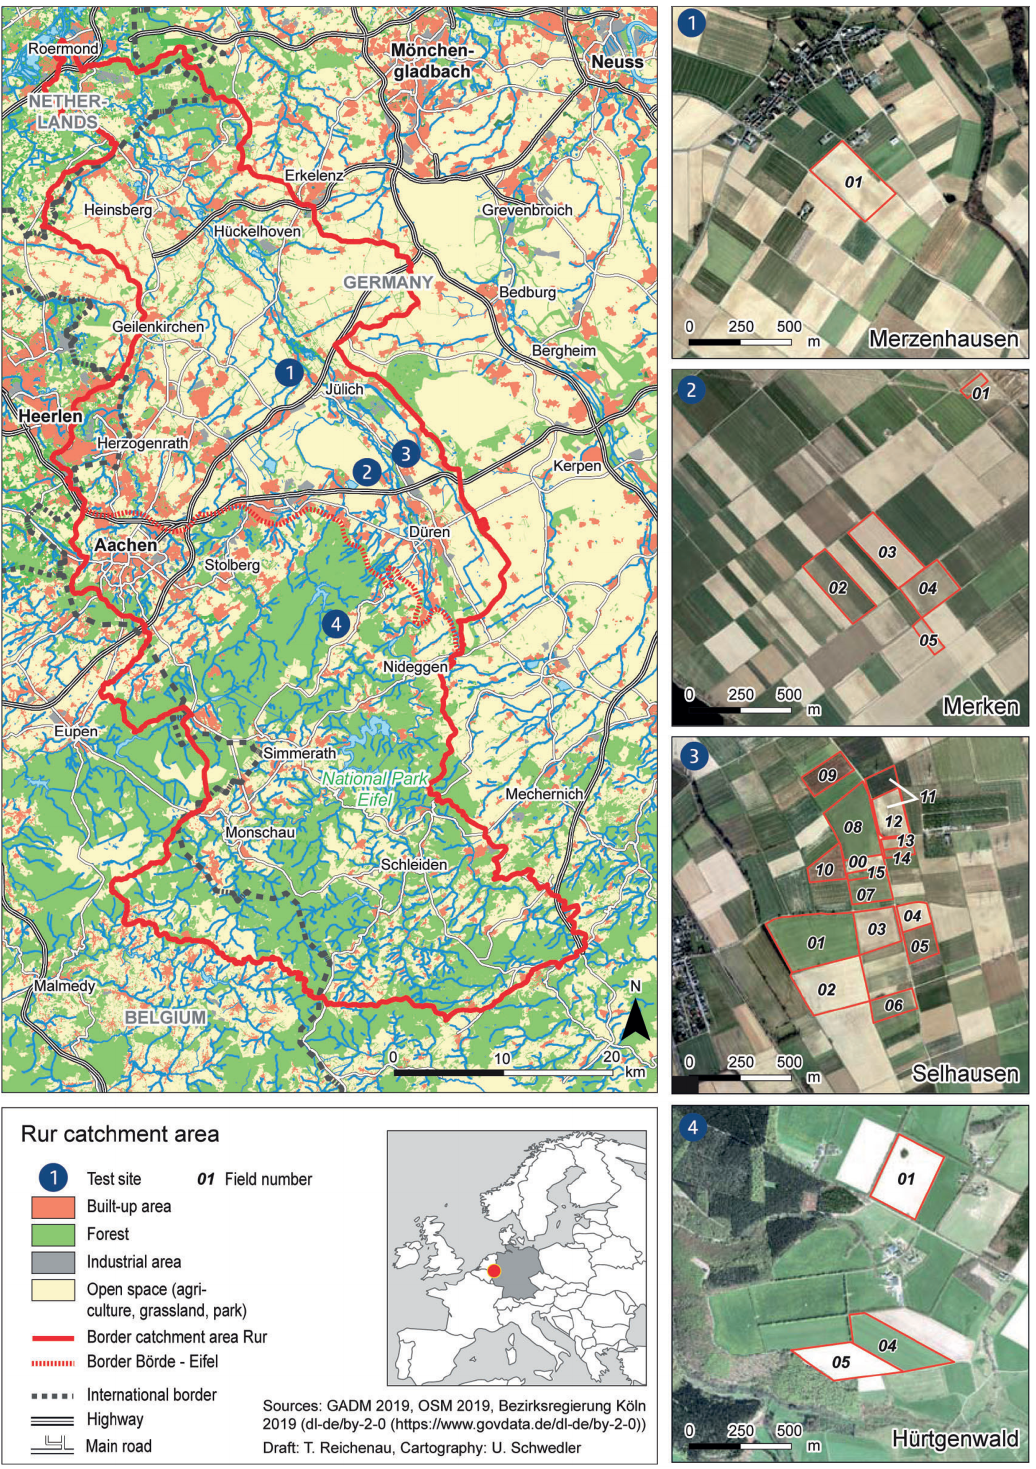
Figure 1. Left: locations of the observation sites in the Rur catchment in Germany. Right: locations of the fields at the observation sites with two-digit field IDs. At the Selhausen site (3), field 12 is a part of field 11. In the aerial photo of the Merken site (2), a part of field 01 is within the area of an open-pit mine. At the time of field measurements, the mine was about 2.5km away from the field. Map data: